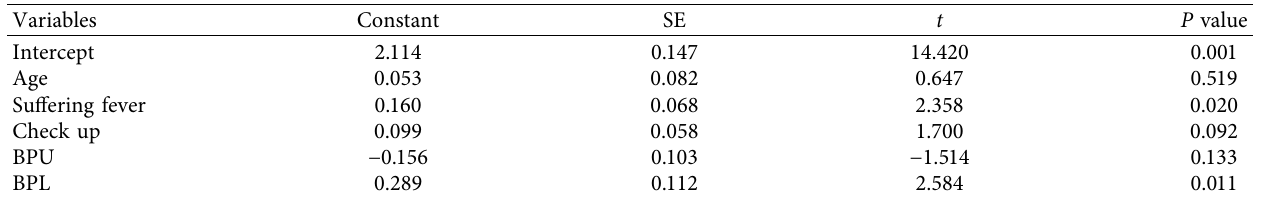
Table 5: Result of fuzzy multiple regression when fuzzy independent variables and crisp-dependent variable in trapezoidal membership